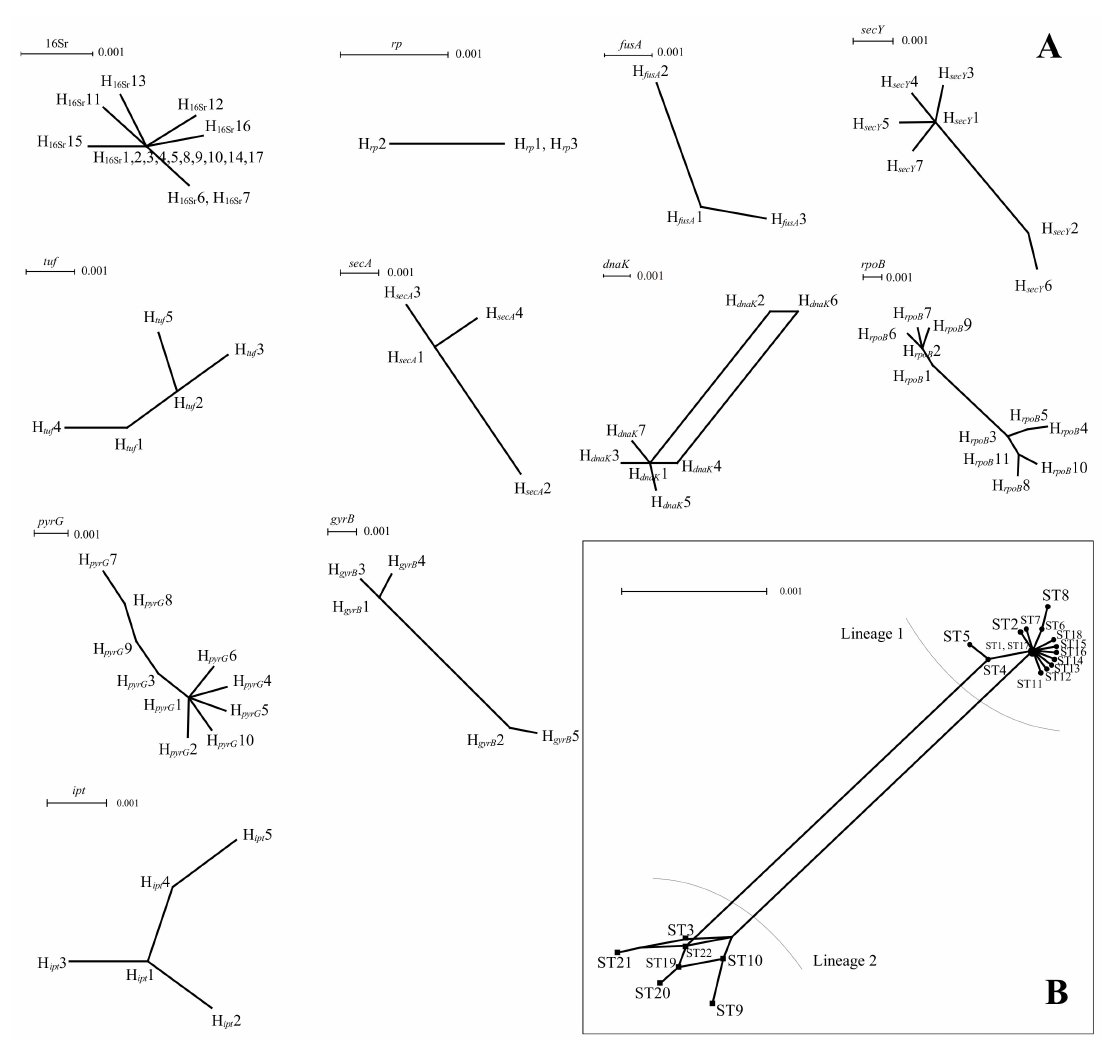
Figure 3. ( A ) Split network of PaWB phytoplasma strains based on each housekeeping gene. ( B ) Split network of PaWB phytoplasma strains based on concatenate sequences of 7 housekeeping